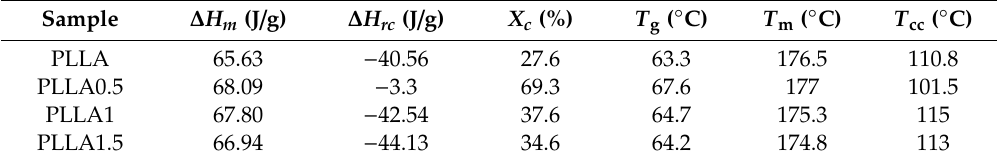
Table 3. The non-isothermal melt crystallization parameters of pure PLLA and composites.